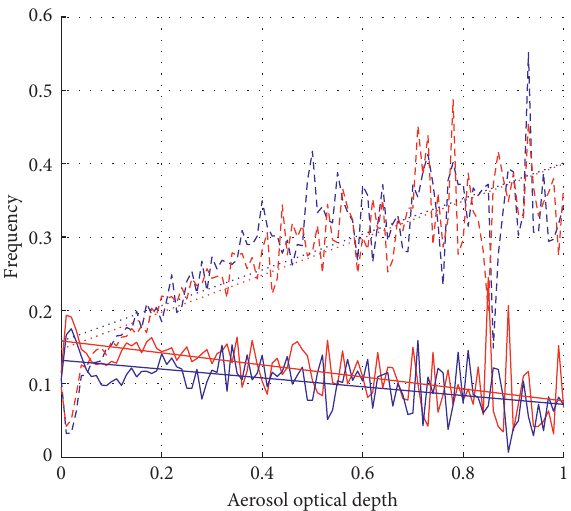
Figure 4: Comparison of the frequency of dust and polluted aerosol in abundant and deficient monsoon years (“blue solid line” is the dust aerosol of abundant monsoon years; “red solid line” is the dust aerosol of deficient monsoon years; “blue dotted line ” is the polluted aerosol of abundant monsoon years; “red dotted line” is the polluted aerosol of deficient monsoon years).